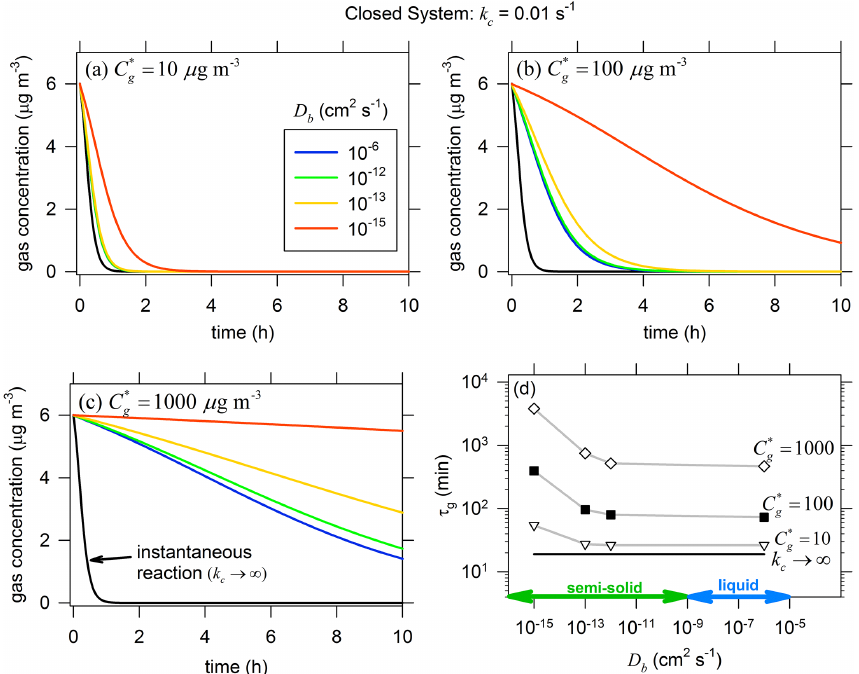
Figure 15. Gas-phase concentration decay due to kinetic SOA partitioning with particle-phase reaction ( k c = 0.01s − 1 ) for bulk diffusivities ranging from 10 − 6 to 10 − 15 cm 2 s − 1 and three gas volatilities: (a) C ∗ g = 10µgm − 3 , (b) C ∗ g = 100µgm − 3 , and (c) C ∗ g = 1000µgm − 3 . Each plot also shows gas-phase concentration decay for the reference case of instantaneous reaction (black line, k c → ∞ ) . In each case, the final concentration of the newly formed SOA is 6µgm − 3 . Panel (d) shows the plot of gas-phase concentration decay timescale ( τ g ) as a function of D b for the different gas